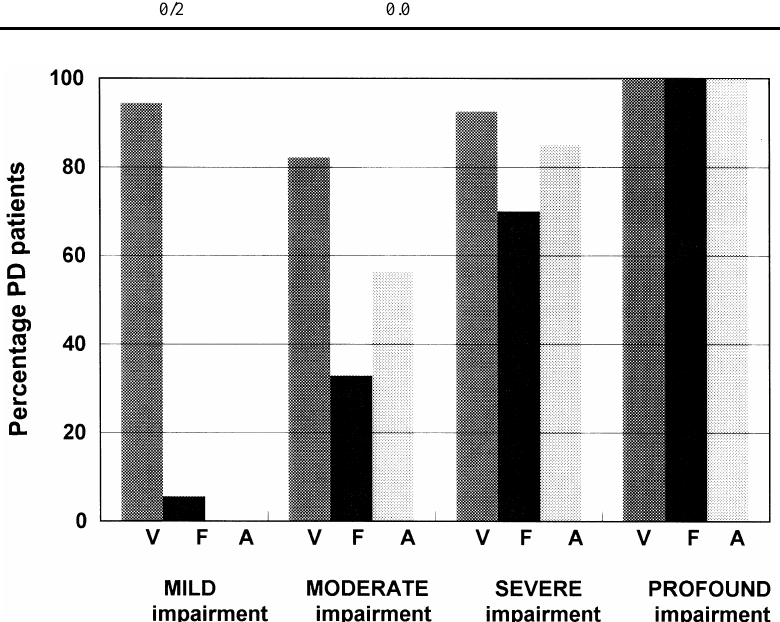
Fig. 1. Percentage of voice (V), fluency (F) and articulatory (A) impairment for each category of